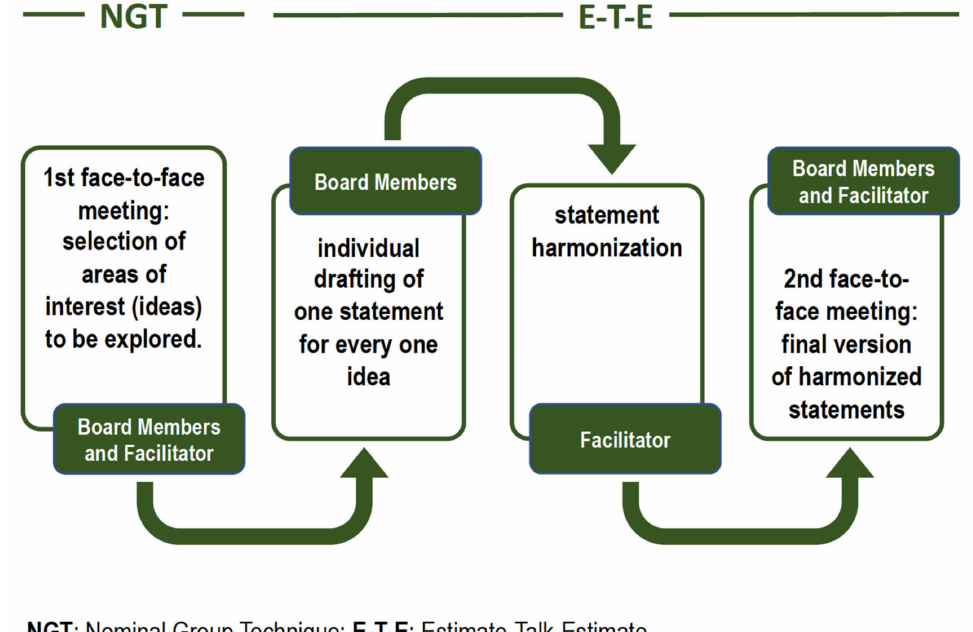
Figure 1. Overall process used to obtain consensus.